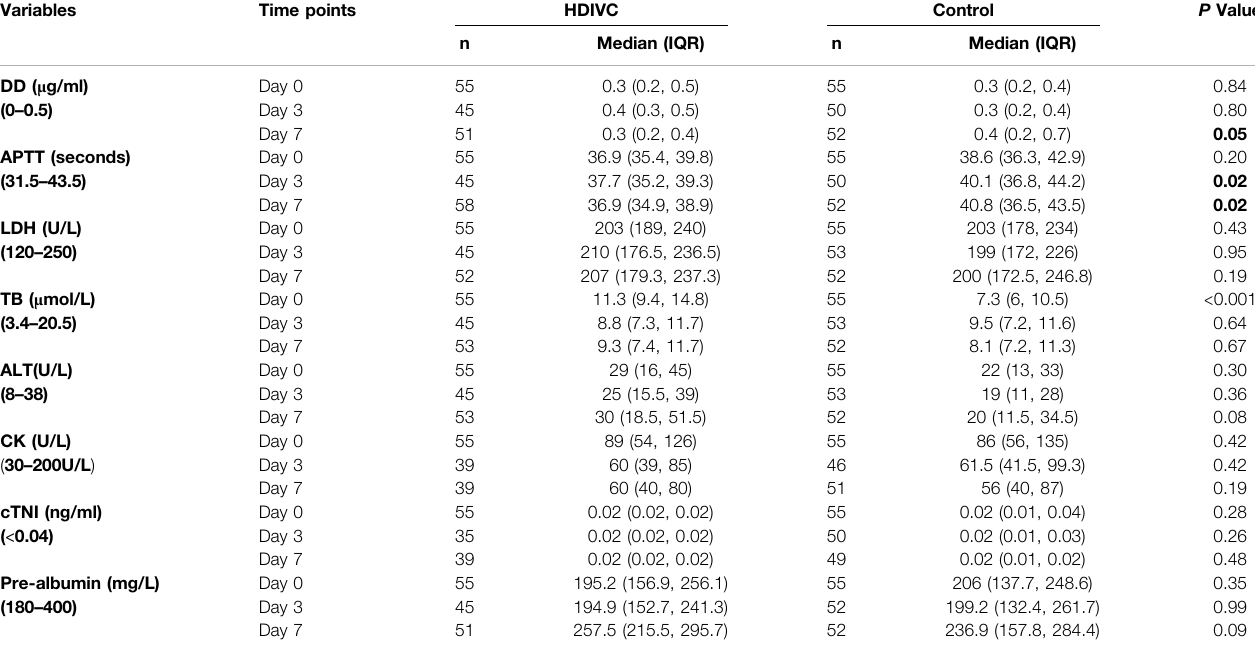
TABLE 4 | Effect of HDIVC on organ functions.